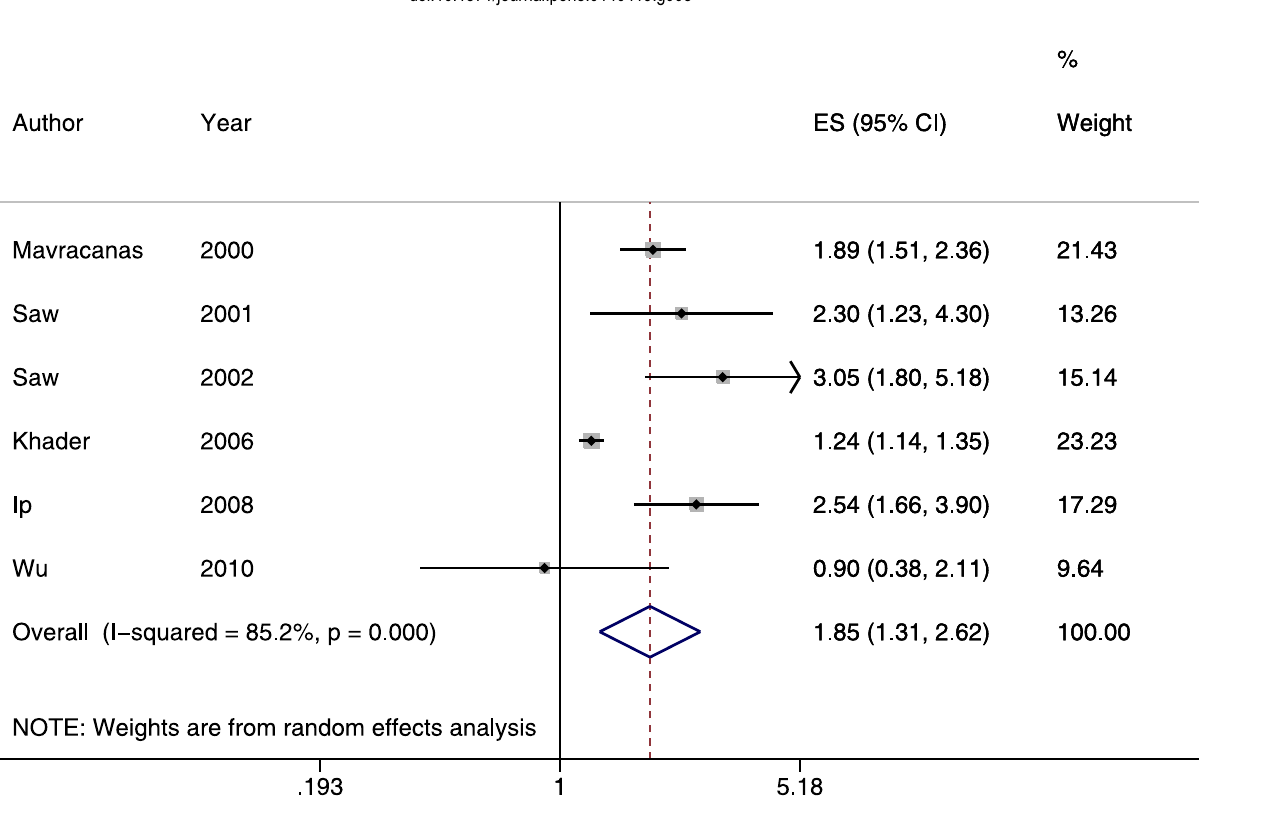
Fig 4. Subgroup of studies reporting the association between near work (dichotomized) and prevalence of myopia (odds ratio). A pooled odds ratio of 1.85 (95% CI: 1.31 – 2.62) indicated that children who performed more near work were more likely to be myopic.